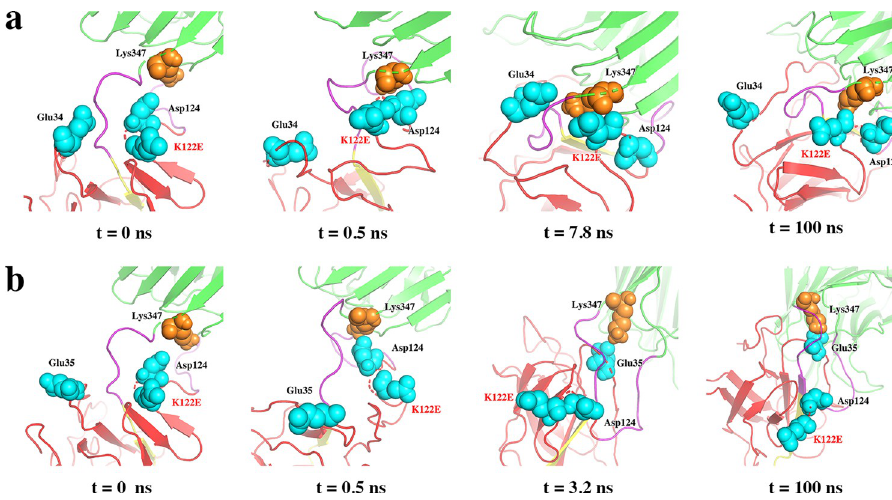
Fig 3. Structure in simulated trajectory of K122E. (a) and (b) are two simulation results. (a) Glu122 and Asp124 interacted with Lys347 first and lasted until the end; Glu34 was also very close to Lys347, but eventually left. (b) Both Glu122 and Asp124 were first closed to Lys347, and then left. On the contrary, Glu35 approached Lys347 later and remained in this state untill the end of the